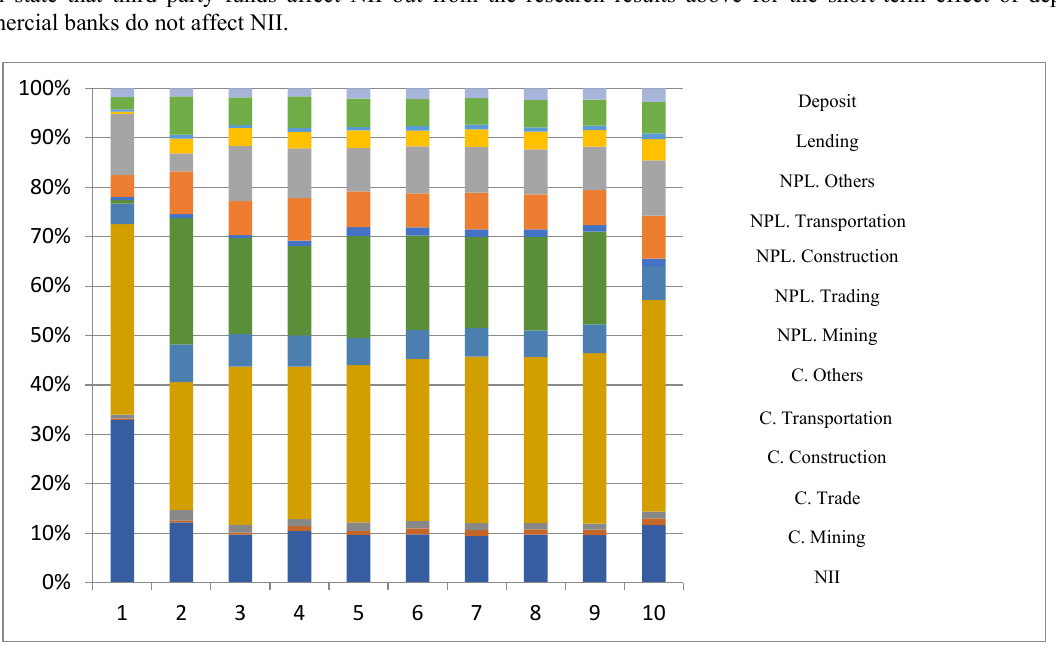
Fig. 13. Variance Decomposition of